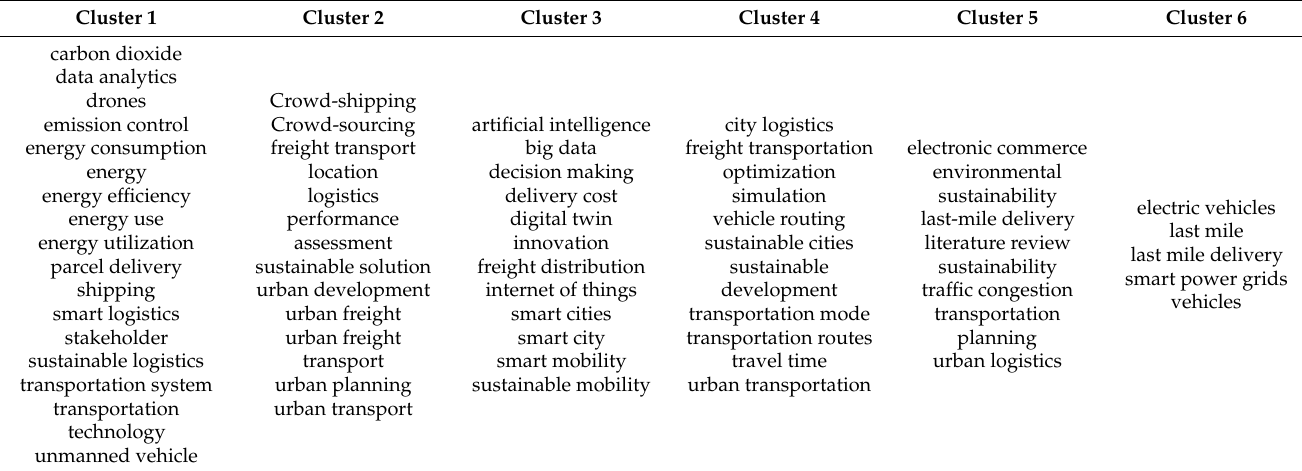
Table 3. Clustering of keywords based on results from